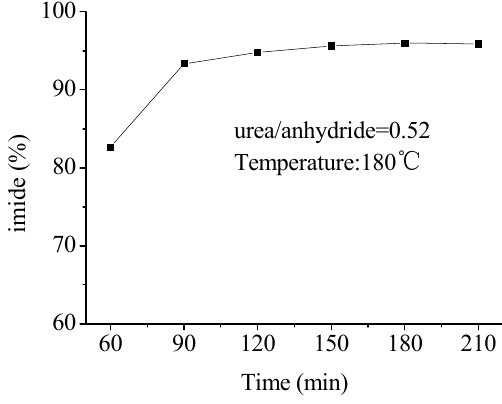
Figure 2. Effects of the reaction time on the content of imide.